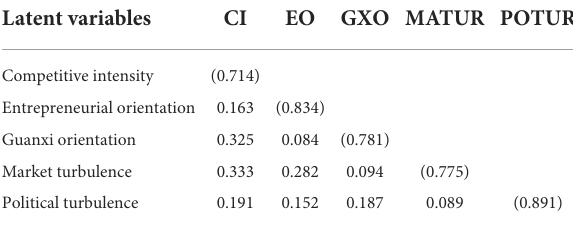
TABLE 3 Results of discriminant